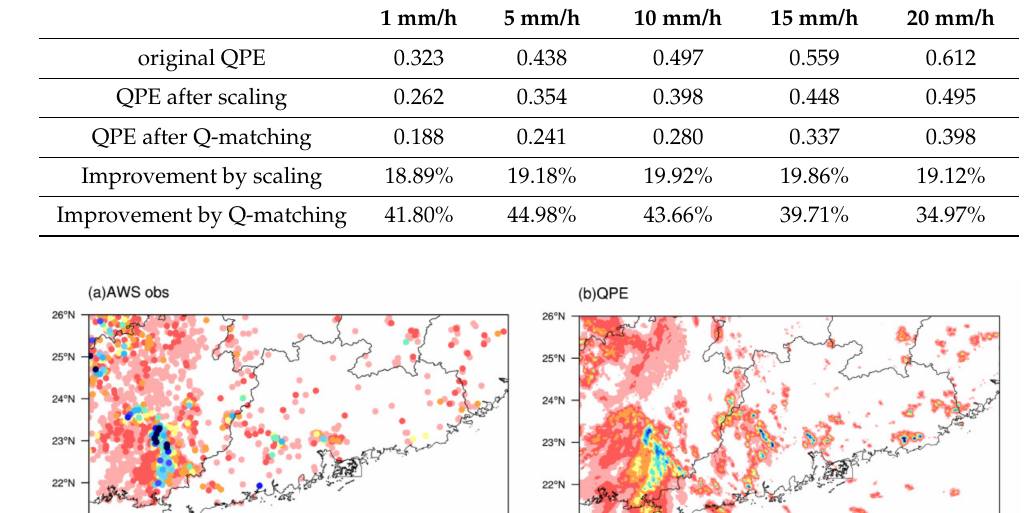
Table 3. Same as Table 2 but for the results of the FAR scores.